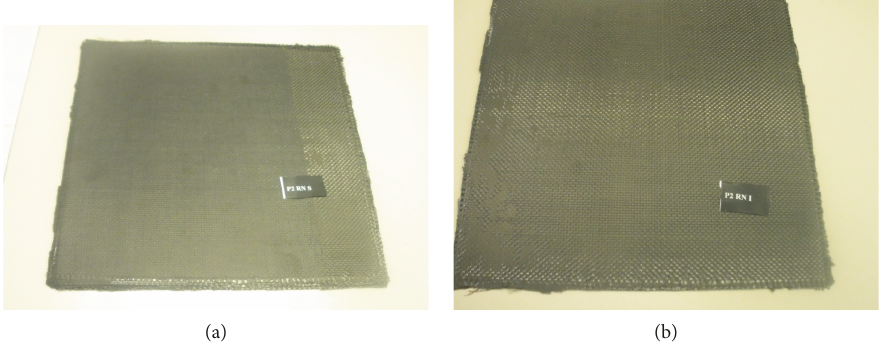
Figure 4: Final panel: (a) upper side and (b) lower side.